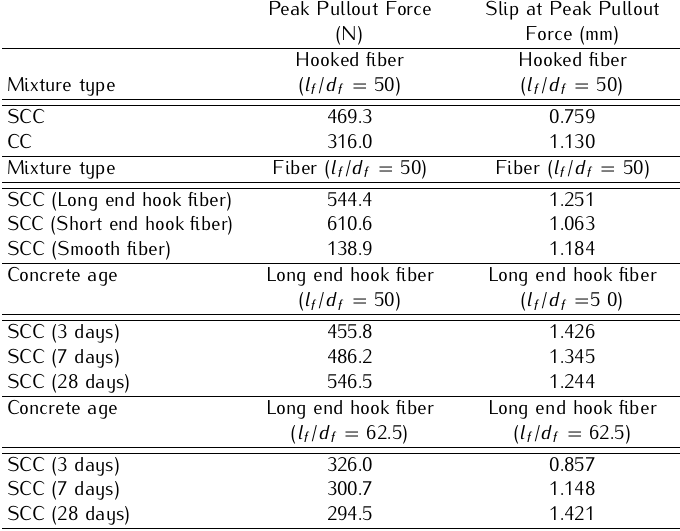
Table 3. Experimental results from the Holschemacher and Klug [28].